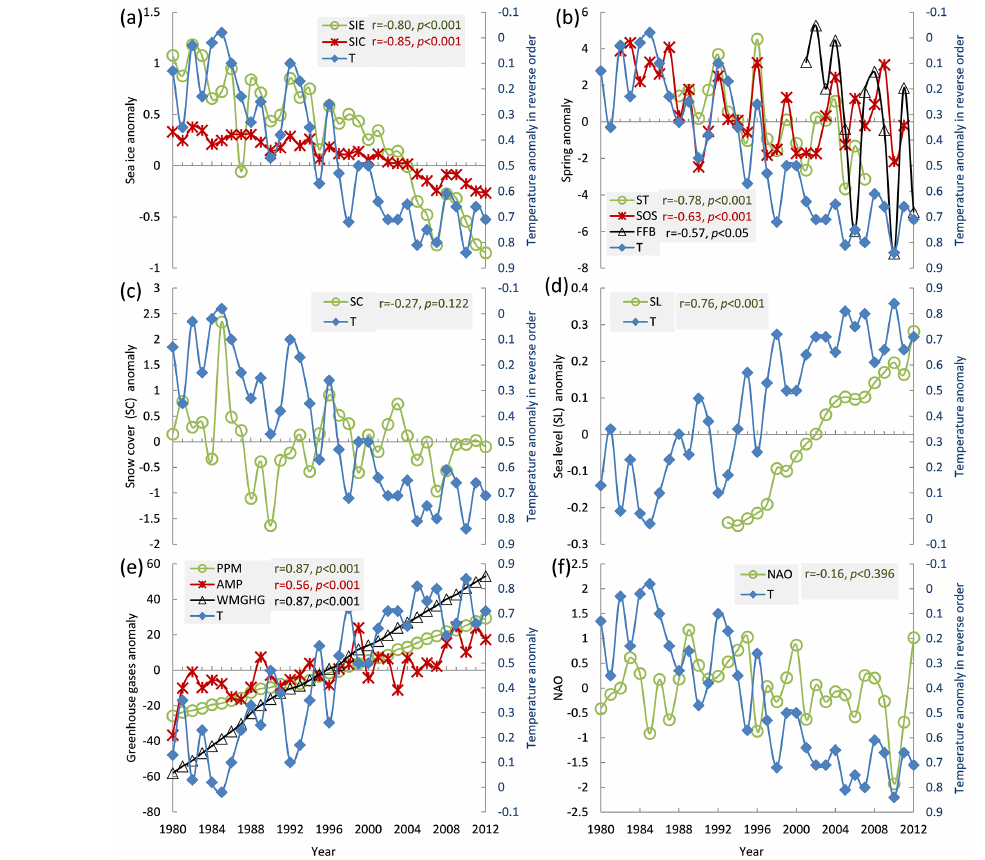
Figure 2. Relationship between land, cryosphere and ocean indicators, and recent trends in surface temperature. Surface temperature anomaly is from the Northern Hemisphere relative to 1951–1980. The r (Pearson correlation coefficient) and p ( p value) are given for long-term relationships between temperature and the plotted variables. (a) Sea ice concentration (SIC) 0 (no ice) to 10 (full ice coverage) anomaly and sea ice extent (SIE) 10 6 km 2 anomaly of circumpolar Northern Hemisphere region ( > 31 ◦ N) relative to 1993–2012 normals. (b) Spring thaw (ST) and start of growing season (SOS) day anomalies of northern ecosystems ( > 45 ◦ N) relative to 1988–2007 normals (ref. Barichivich et al., 2013, modified) and first flower bloom (FFB) day anomaly of Canada relative to 2001–2012 normals (ref. Gonsamo et al., 2013, modified). (c) Snow cover (SC) 10 6 km 2 anomaly of Northern Hemisphere relative to 1993–2012 normals. (d) Sea level (SL) 10 2 mm anomaly of Northern Hemisphere relative to 1993–2012 normals. (e) Peak-to-trough amplitude (AMP) 10 1 and concentration (PPM) of atmospheric CO 2 at Point Barrow and 20 global well-mixed greenhouse gases (WMGHG) radiative forcing. (f) The North Atlantic Oscillation (NAO)